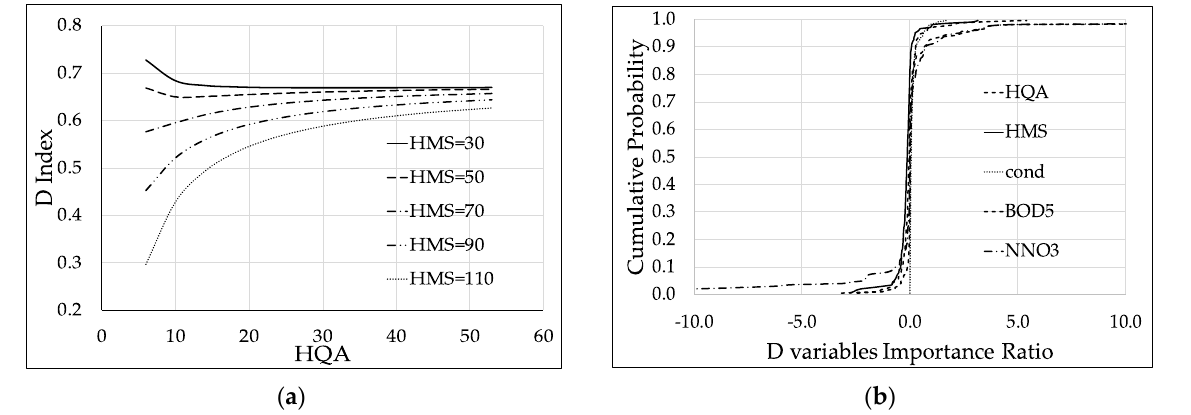
Figure 4. ( a )HMS-HQA nonlinear relationship with D; ( b ) importance ratio of independent variables with D.